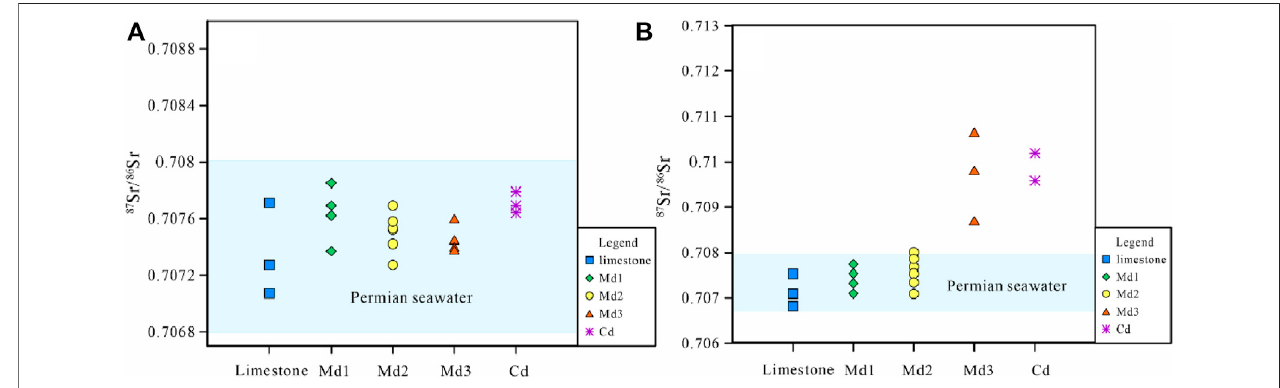
FIGURE6| 87 Sr/ 86 SrratiosoflimestonesandfourtypesofdolomitescomparedtothePermianseawater(0.70680 – 0.70807)(Veizeretal.,1999;Korteetal.,2006; Wang et al., 2019; Dong et al., 2020). (A) Northwestern (NW) study area; (B) southwestern (SW) study area.